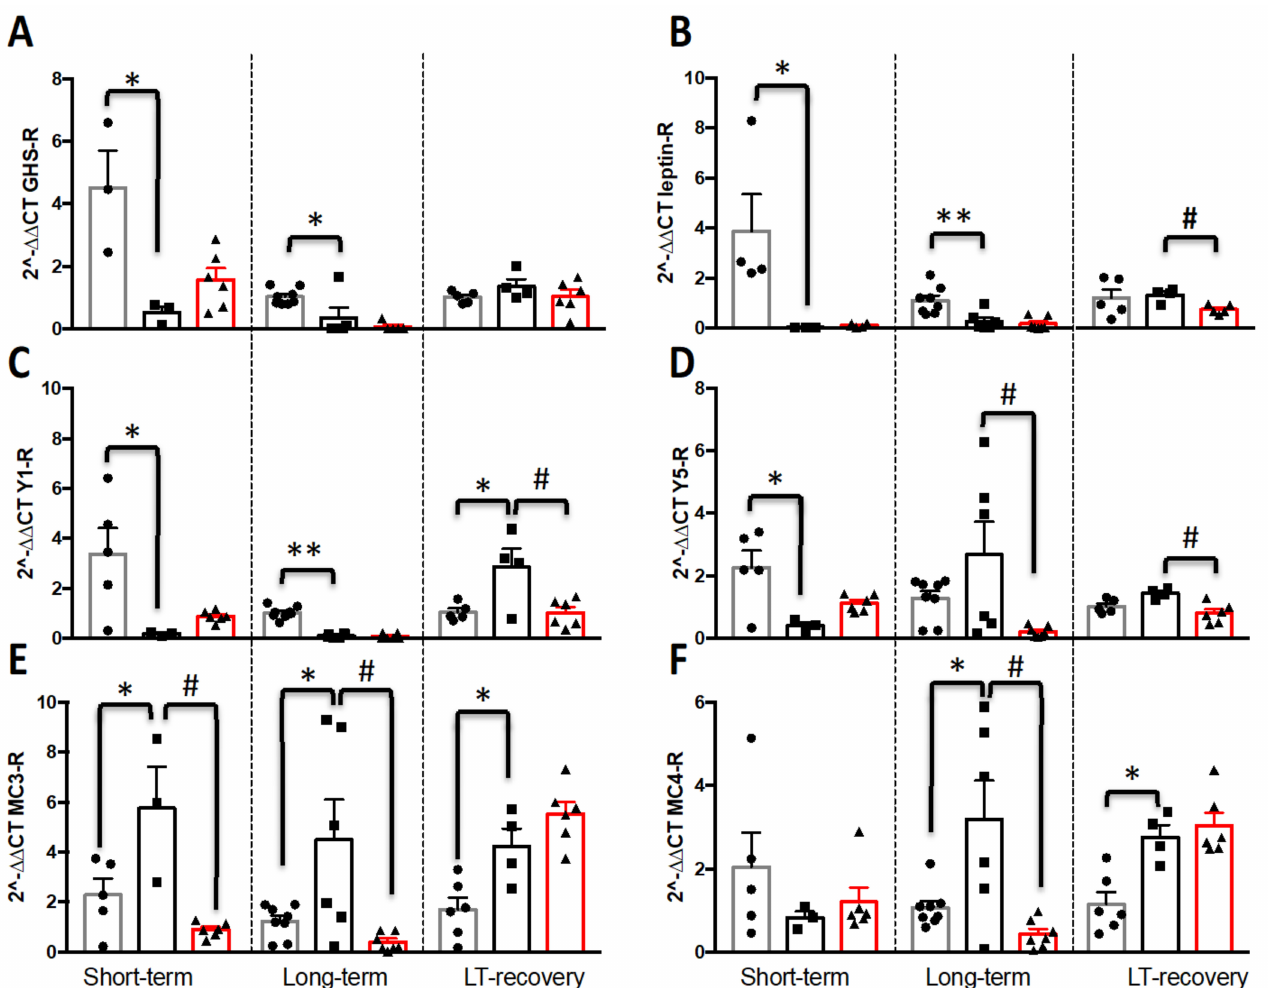
Figure 6. Impact of short-term, long-term (LT) and nutritional recovery (LT-Rec) on the mRNA expression of hypothalamic of ( A ) ghrelin receptor (GHSR), ( B ) leptin receptor, ( C ) Y1-receptor, ( D ) Y5-receptor, ( E ) melanocortin 3-receptor, ( F ) melanocortin 4-receptor. AL: ad libitum ; FR: food restricted; FRW: food restricted with wheel. Data represent mean ± SEM ( n = 3–8 per group). * p < 0.05 AL vs. FR; # p < 0.05 FR vs. FRW; ** p < 0.01 AL vs.